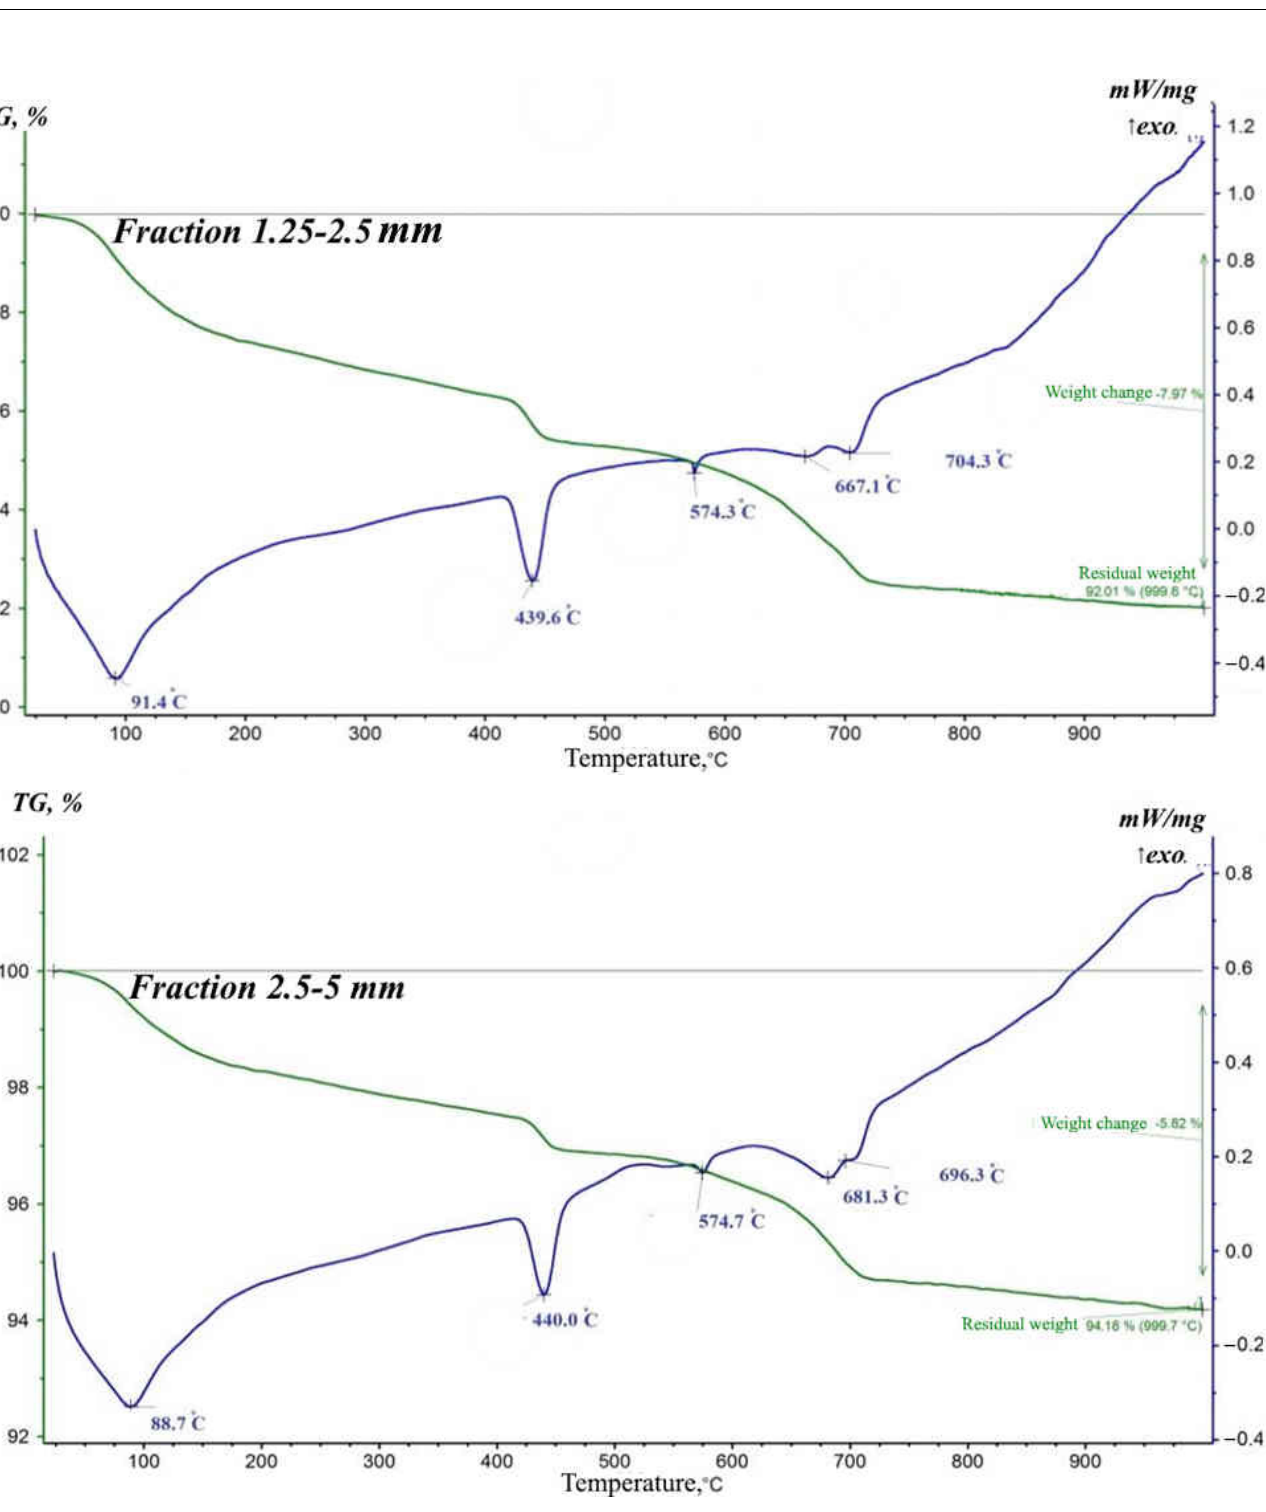
Figure 4. Differential thermal analysis of various fractions of concrete scrap crushing screenings.